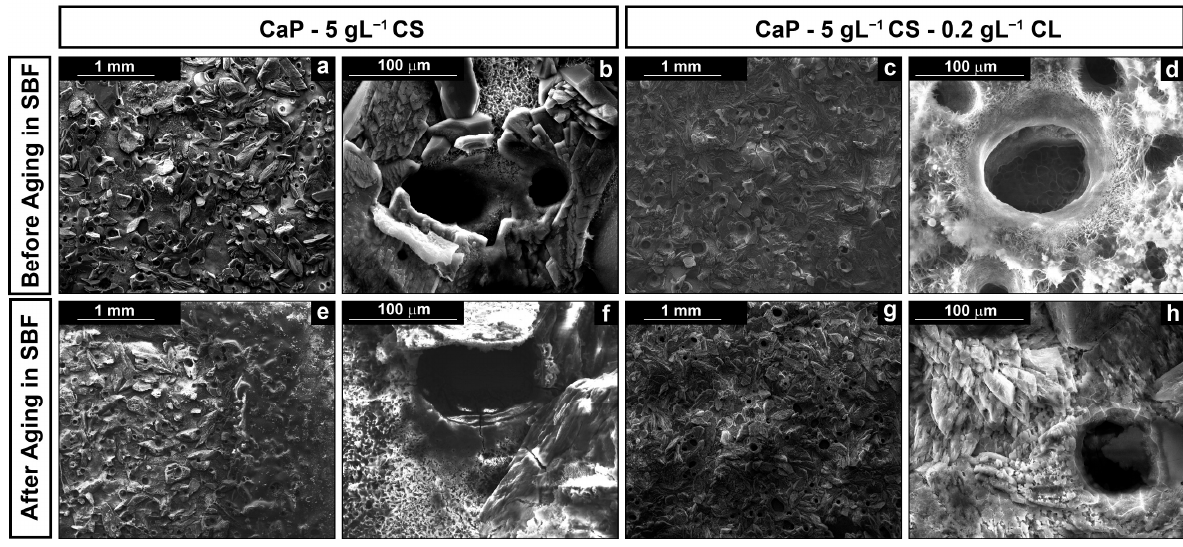
Figure 1. SEM images of the surface of the coatings at different magnifications: ( a , b ) CaP/CS and ( c , d ) CaP/CS/CL before aging; ( e , f ) CaP/CS and ( g , h ) CaP/CS/CL after aging in SBF.